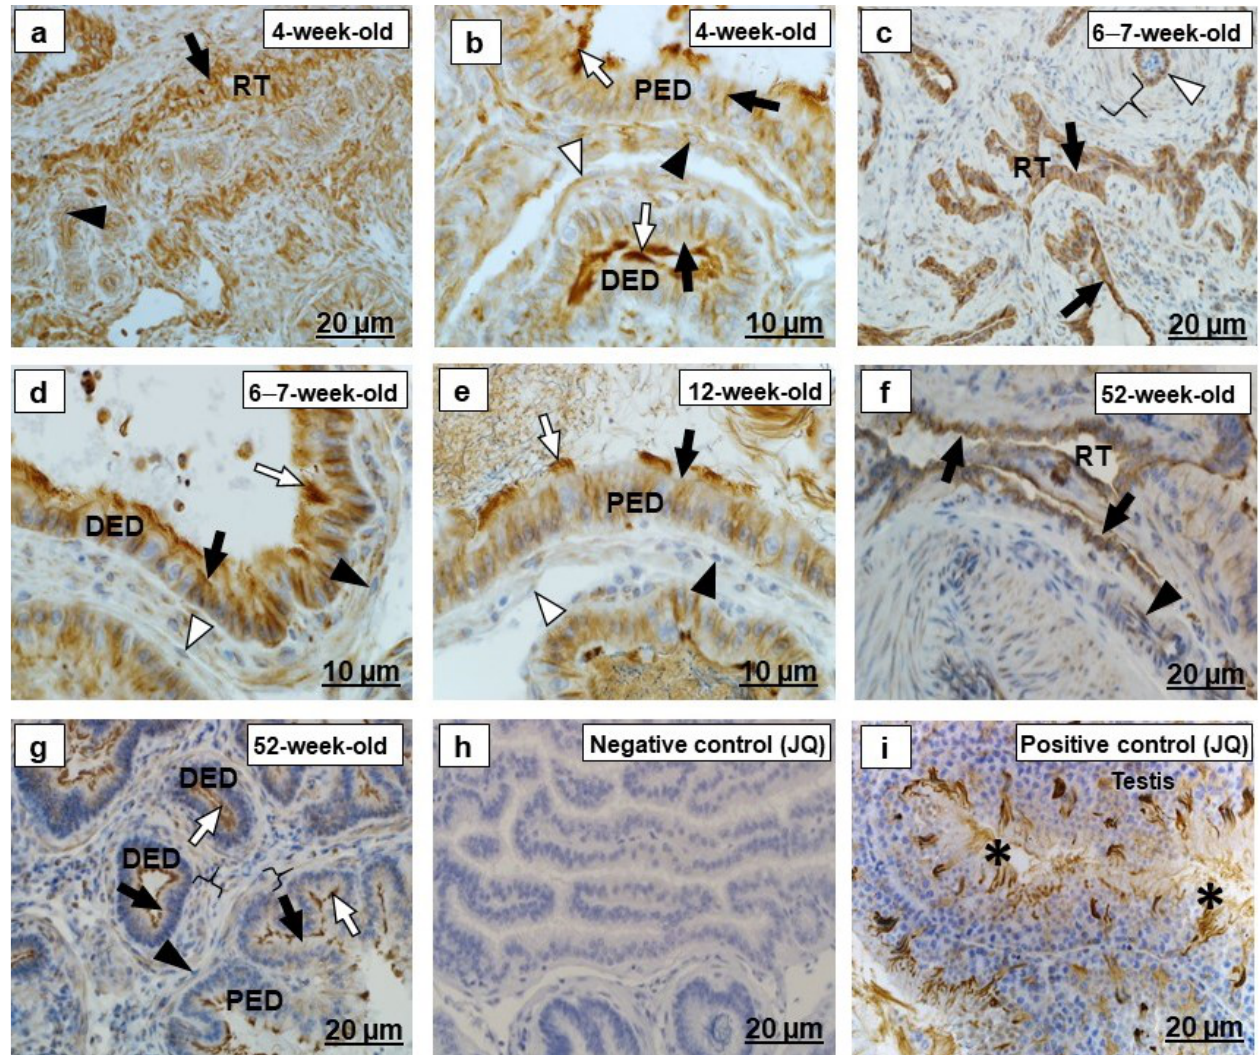
Figure 6. Beta-tubulin immunolocalization in the (RT) rete testis, (PED) proximal efferent duct and (DED) distal efferent duct of the testicular excurrent duct system of Japanese quails ( n = 7 per age group). ( a ) Strong immunostaining in the RT epithelium (black arrow) and vascular endothelial